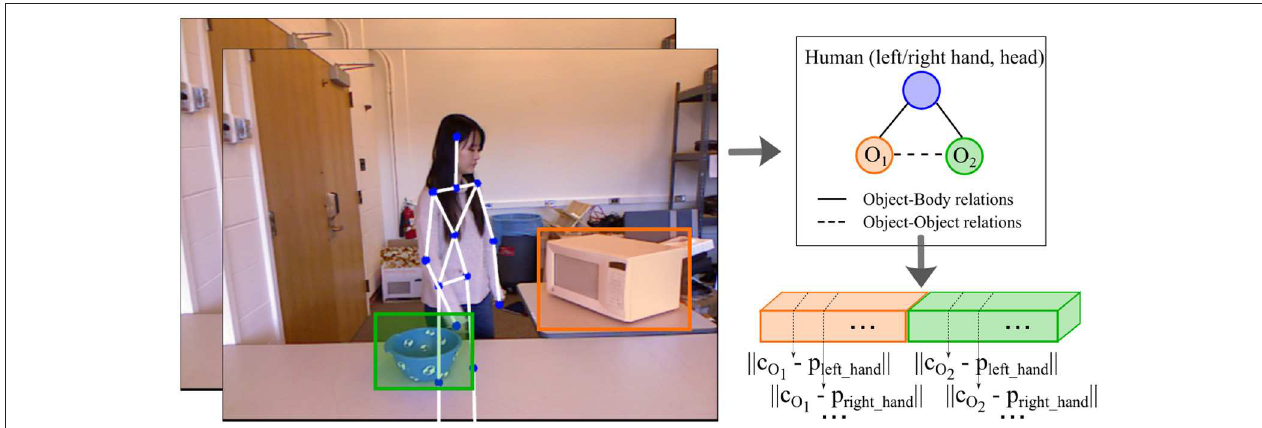
FIGURE 5 | An illustration of how we represent the spatial relationships between objects and humans in a scene from the CAD-120 dataset (Mici, 2018). We extract , and compute the Euclidean distance between them and the left hand , right hand , and head joints. This is and c O the three-dimensional centroids of the objects, c O 2 1 then concatenated to the Euclidean distances between the objects’ centroids. In this example, the person first interacts with the microwave and then with the bowl. Hence, the tracks of the microwave will take the first place in the concatenated vector of the spatial